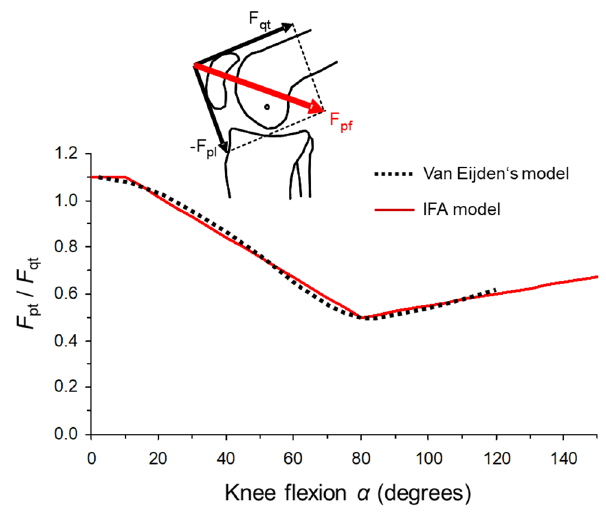
Figure 5. Comparison of the ratio of F pl / F qt between patellar ligament force and quadriceps vs knee flexion angle from the IFA model with data presented by Eijden van et al. [27].